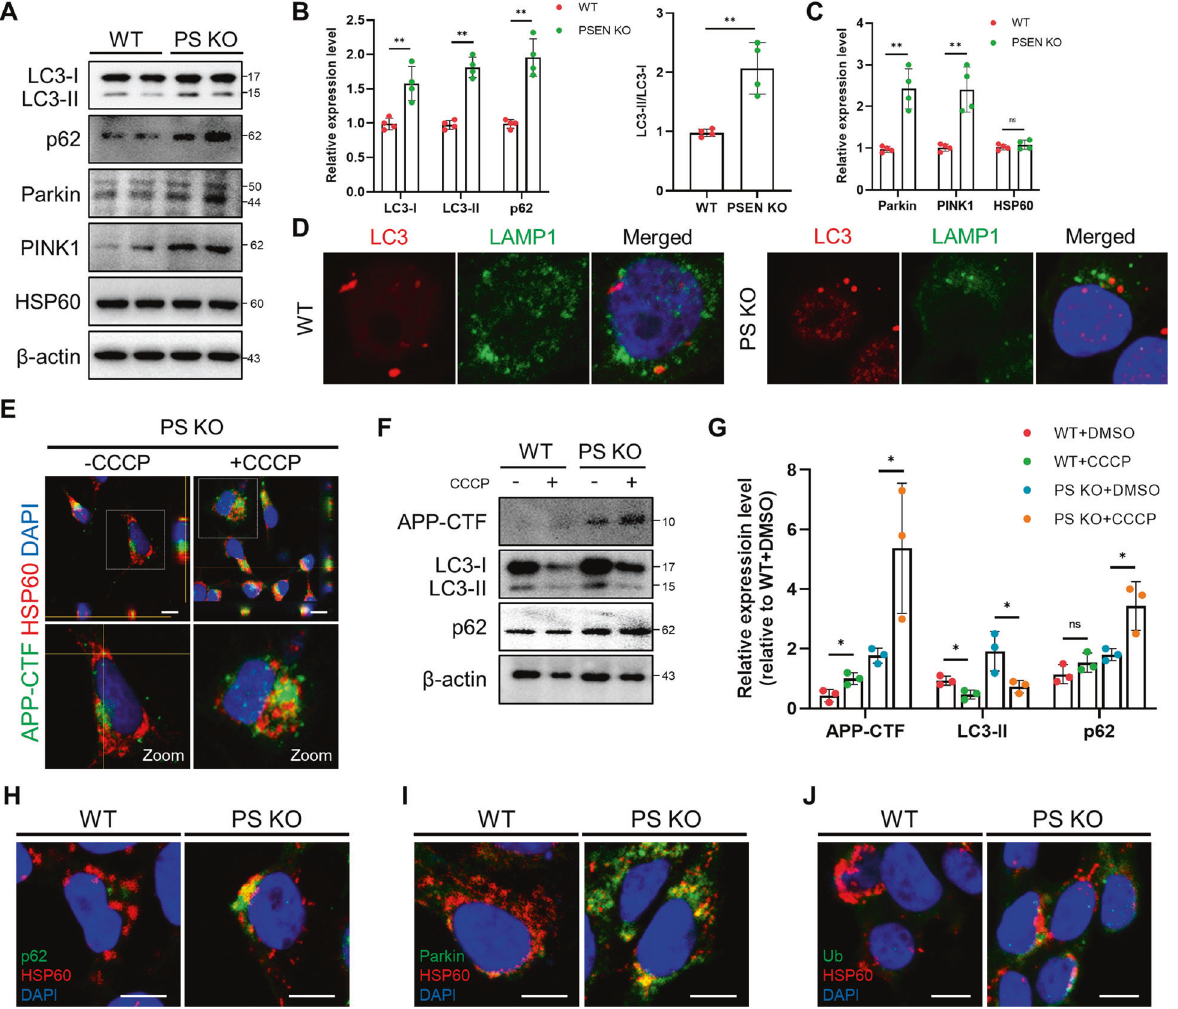
Fig. 5 APP-CTFs accumulation triggers mitophagy failure in PSEN KO-iNSCs. A Representative western blotting showed mitophagy-related proteins, including LC3, p62, Parkin, PINK1, and HSP60, in WT- and PSEN KO-iNSCs. B Protein levels of LC3 and p62 in WT- and PSEN KO-iNSCs. C Protein levels of Parkin, PINK1, and HSP60 in WT- and PSEN KO-iNSCs. D Representative images showing LC3 and LAMP1 in WT- and PSEN KO-iNSCs under basal conditions. E Representative images of APP-CTFs and HSP60 protein in the absence or presence of CCCP (20 μ M). Scale bars, 10 µm. F Representative western blot of LC3 and p62 in vehicle- or CCCP (20 μ M)-treated WT- and PSEN KO-iNSCs. G Quanti fi cation of the levels in the absence or presence of CCCP. H Representative images of WT- and PSEN KO-iNSCs stained with anti-p62 (green) and anti-HSP60 (red). I Representative images of WT- and PSEN KO-iNSCs stained with anti-Parkin (green) and anti-HSP60 (red). J Representative images of WT- and PSEN KO-iNSCs stained with anti-Ub (green) and anti-HSP60 (red). Scale bar, 10 µm. Statistical analysis was performed by Student ’ s t -test. n.s not signi fi cant, * P < 0.05 and ** P < 0.01. The results are presented as the means ±